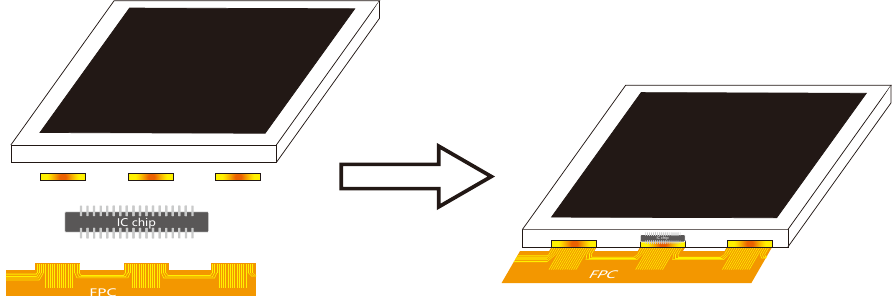
Figure 1. ACF can reduce the size of the LCD module and achieve a higher level of integration.